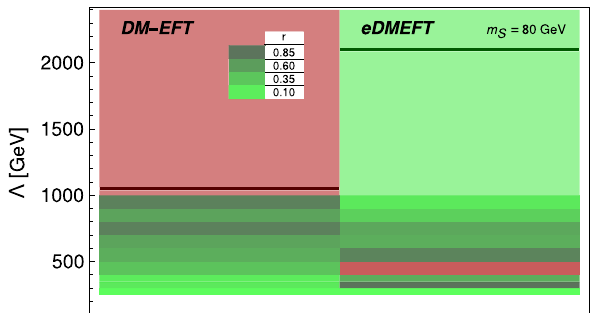
Fig. 5 Comparison of limits on the cutoff scale (cid:7) from an LHC mono- jet analysis [29], depicted as black lines, in the conventional DM EFT (left) and the eDMEFT (right), with (considering quark-induced pro- duction) C D1 = 1, ( y S u ) 11 = 1 = y S , m χ = 1GeV, and m S = 80GeV. The red regions indicate those bins (in / E T ) that lead to an exclusion at the 95% CL level, while the darker the green the closer the corre- sponding cross section is to the experimental bound, see text for details. As can be observed, the limits in the DM EFT are driven by the most energetic bins, above the derived cutoff, thereby invalidating the EFT approach to obtain them (see also [7]). On the other hand, the bounds in the e DMeft including a light mediator stem from much lower bins, which makes them much more